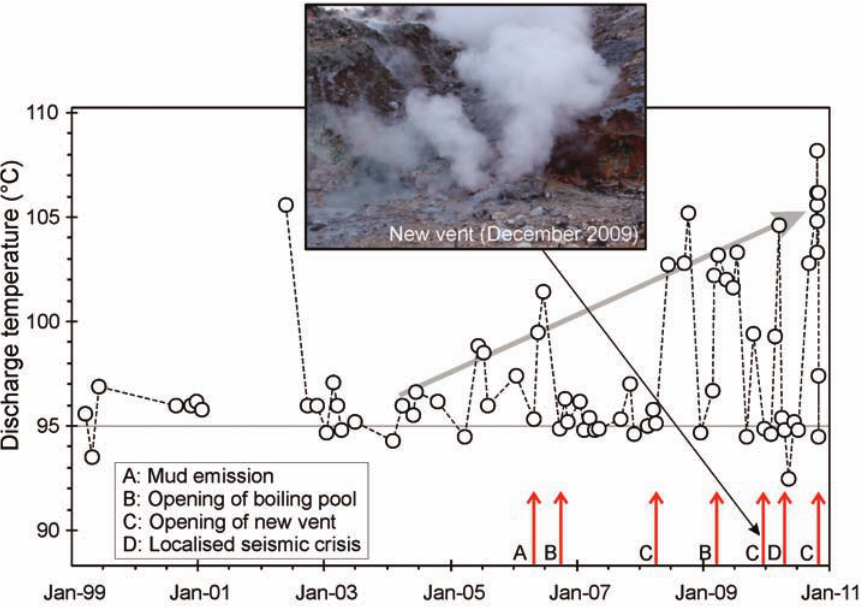
Figure 6. (a) Chronogram of the discharge temperature (˚C) of the Pisciarelli fumarole with the chronological occurrence of the main events (as indicated) linked to the increasing activity. The temperature of 95 ˚C is the boiling temperature for the fumarolic fluids. (b) Photograph of the new roaring fumarole established on December 20,